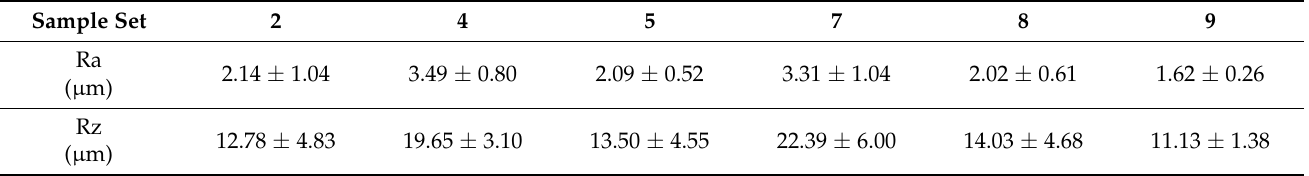
Table 5. Surface roughness results.